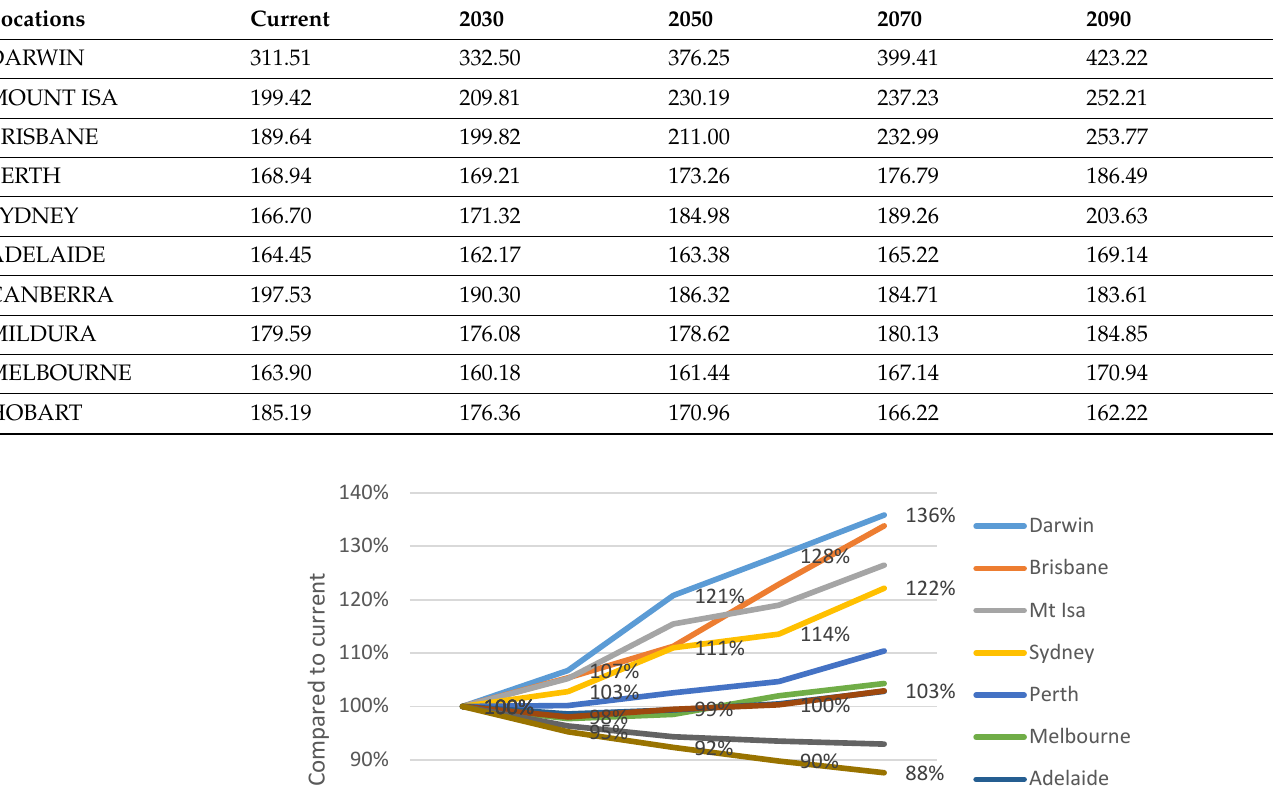
Table 10. Small hospital’s yearly HVAC energy use in kWh/m 2 .